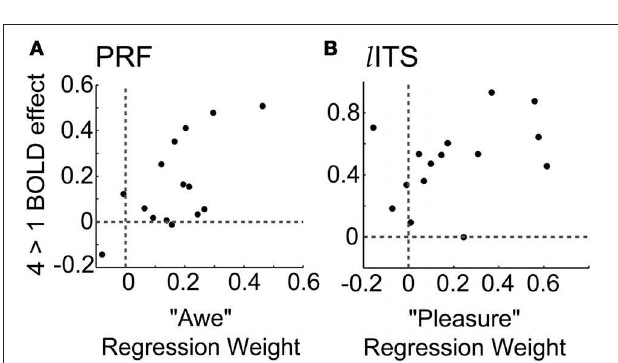
FIGURE 8 | Individual differences in the importance of different evaluations when making aesthetic recommendations are correlated with the size of the BOLD effect in 2 ROIs. (A) Observers for whom “awe” is an important predictor of aesthetic recommendation show a larger 4-vs.-1 BOLD effect size in PRF [ R 2 = 0 . 70; awe beta weight = 1.22, t ( 8 ) = 2 . 88, p = 0 . 021]. (B) Observers for whom “pleasure” is an important predictor of aesthetic recommendation show a larger 4-vs.-1 BOLD effect size in left ITS [ R 2 = 0 . 62; pleasure beta weight 1.72, t ( 8 ) = 2 . 96, p = 0 .